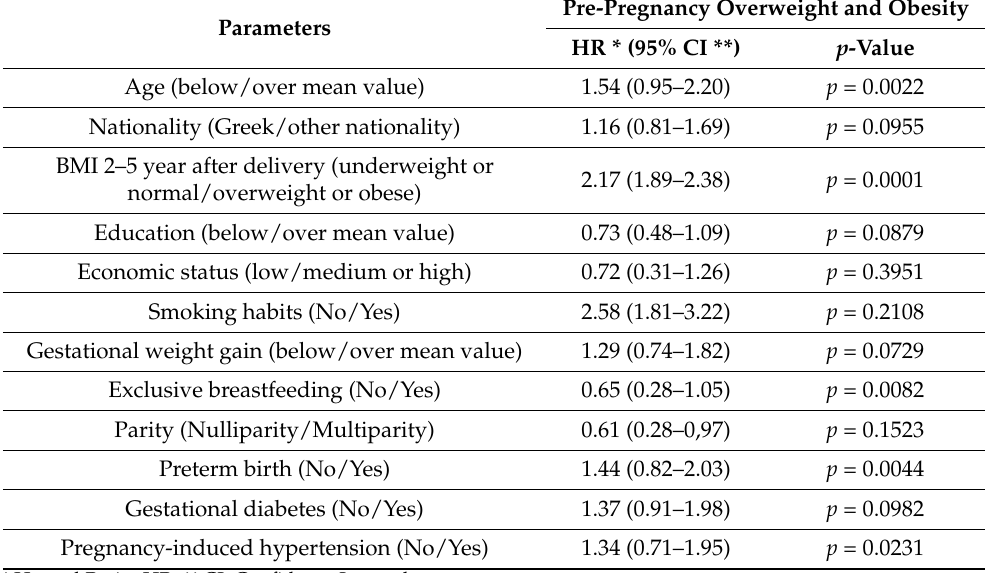
Table 2. Multivariate logistic regression analysis of influence of women’s pre-pregnancy BMI status.